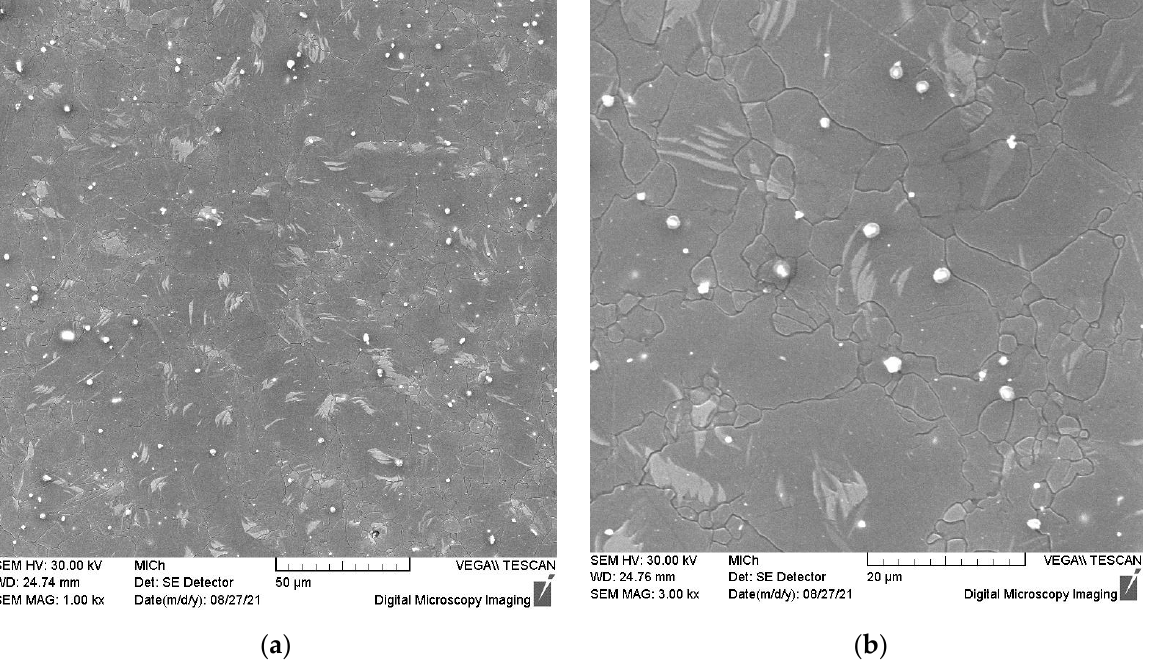
Figure 5. Scanning electron micrograph taken from the perpendicular section of the swaged sample ( a ) and from the higher magnification ( b ).